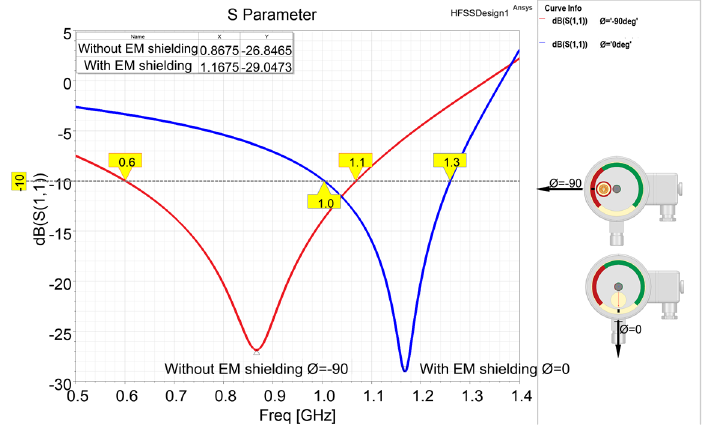
Figure 9. Electromagnetic isolation impact on S11 grape.